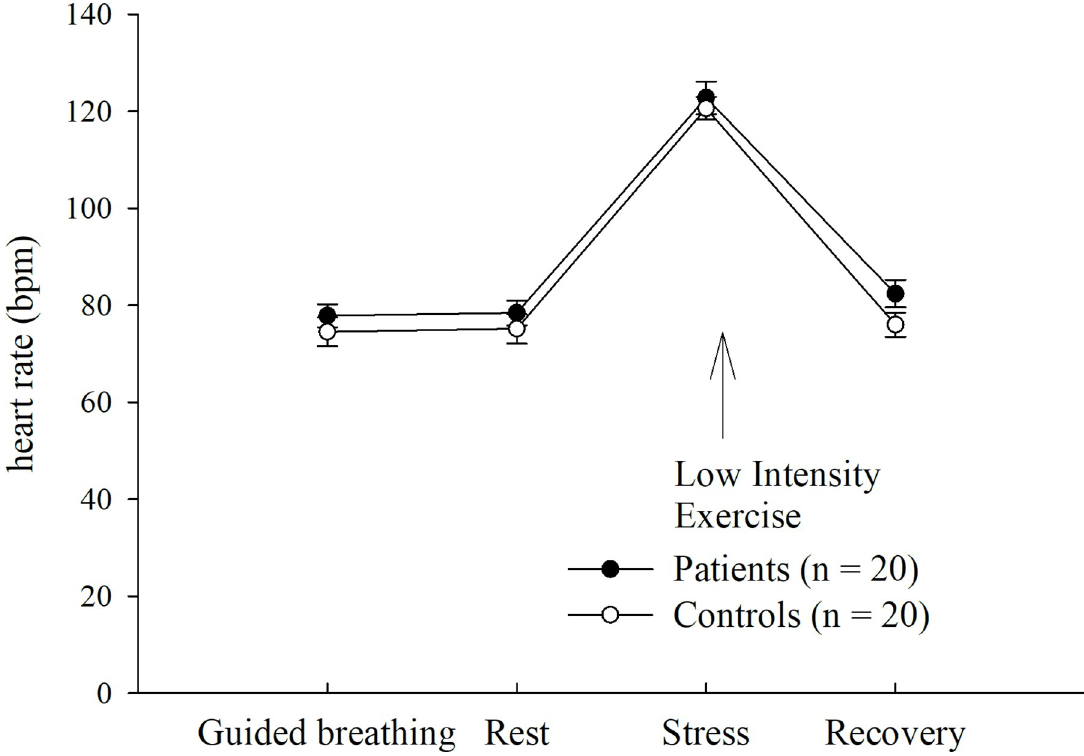
Fig 2. Heart rate response under Low Intensity Exercise (LIE) in patients with panic disorder and healthy controls. Abbreviations / see S3 File: bpm, beats per minute; LIE, low intensity